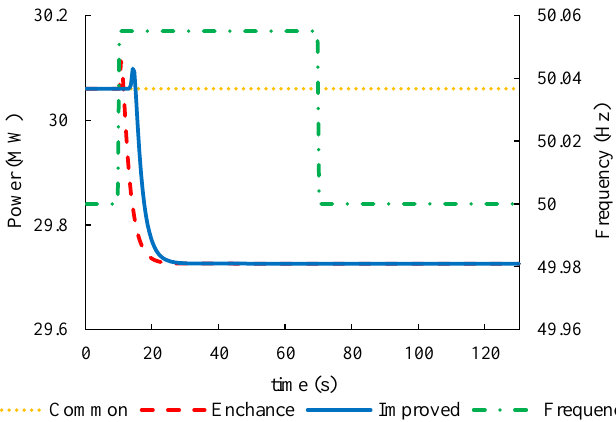
Figure16. TheactivepowercurveofPFCwithcommon, enhanced, andimprovedfrequencydeadzones.